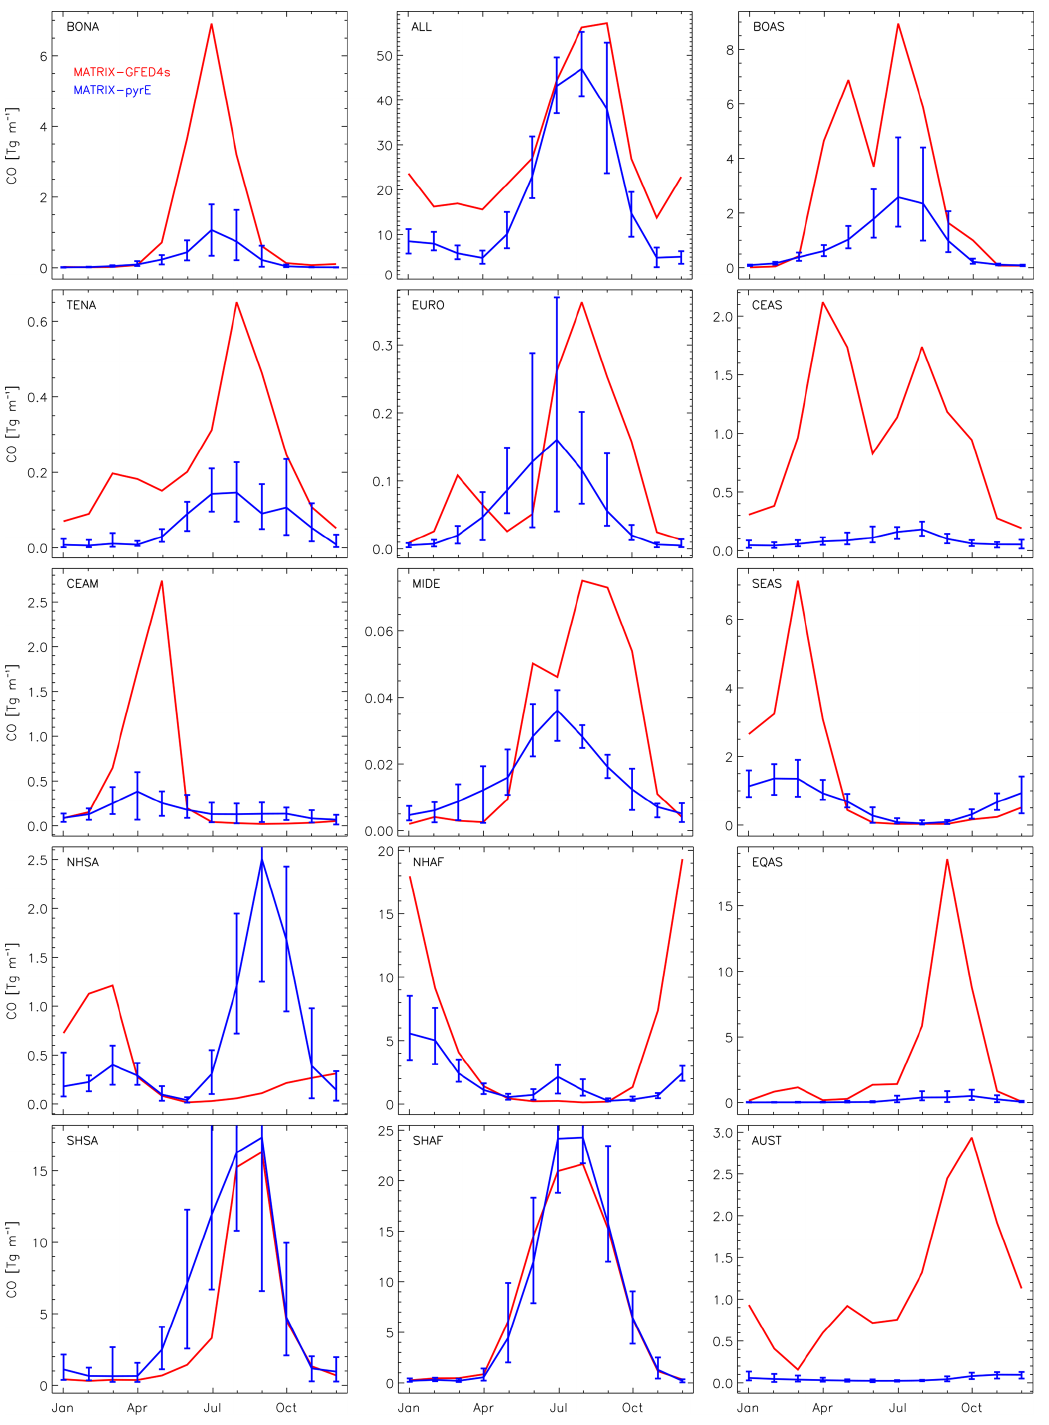
Figure A3. Seasonality of total fire CO emissions simulated (blue) and reported by GFED4s (red) in GFED regions. Error bars represent the 10-year range in the simulations. Note the different scales in each